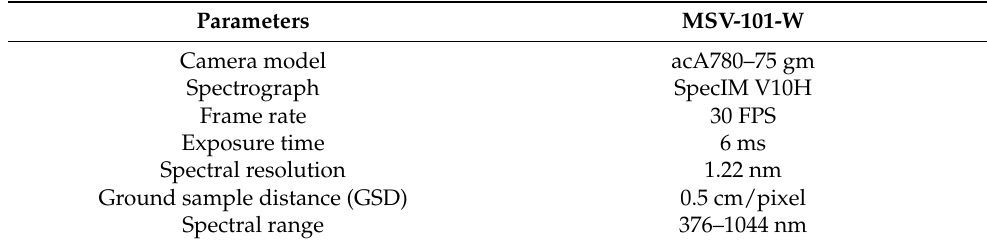
Table 1. Parameters for the hyperspectral imaging